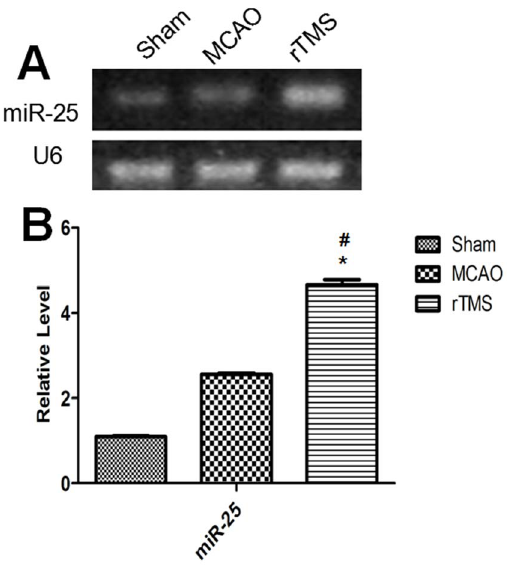
Figure 5. Expression changes of miR-25 in the ipsilateral cortex 7 days after surgery. (A) Electrophoresis of miR-25 and U6 on gel. (B) Relative expressions of miR-25 in different groups. # P , 0.001 compared to the Sham group; * P , 0.001 compared to the MCAO group.